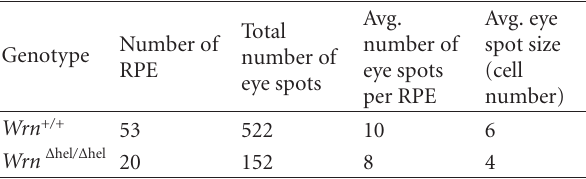
Table 1: Summary of RPE examined and p un reversion frequency by Wrn genotype.